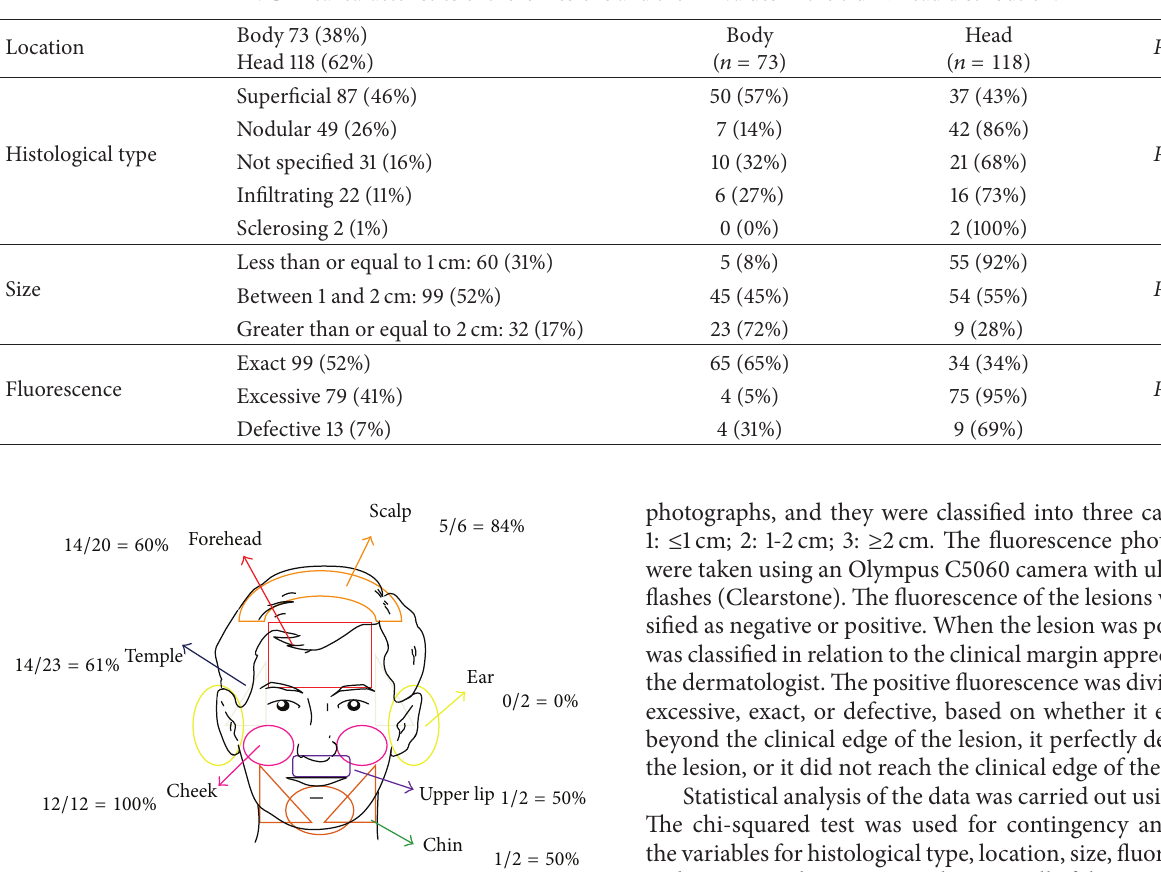
Table 1: Clinical caracteristics of the 191 lesions and their 𝑃 values in the trunk-head distribution.